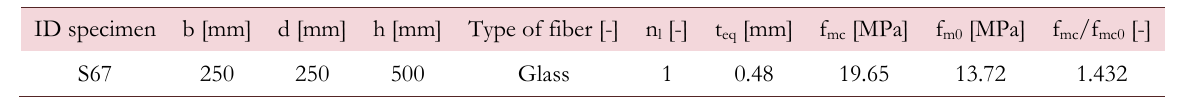
Table 15.B: Geometrical characteristics and experimental results [40].